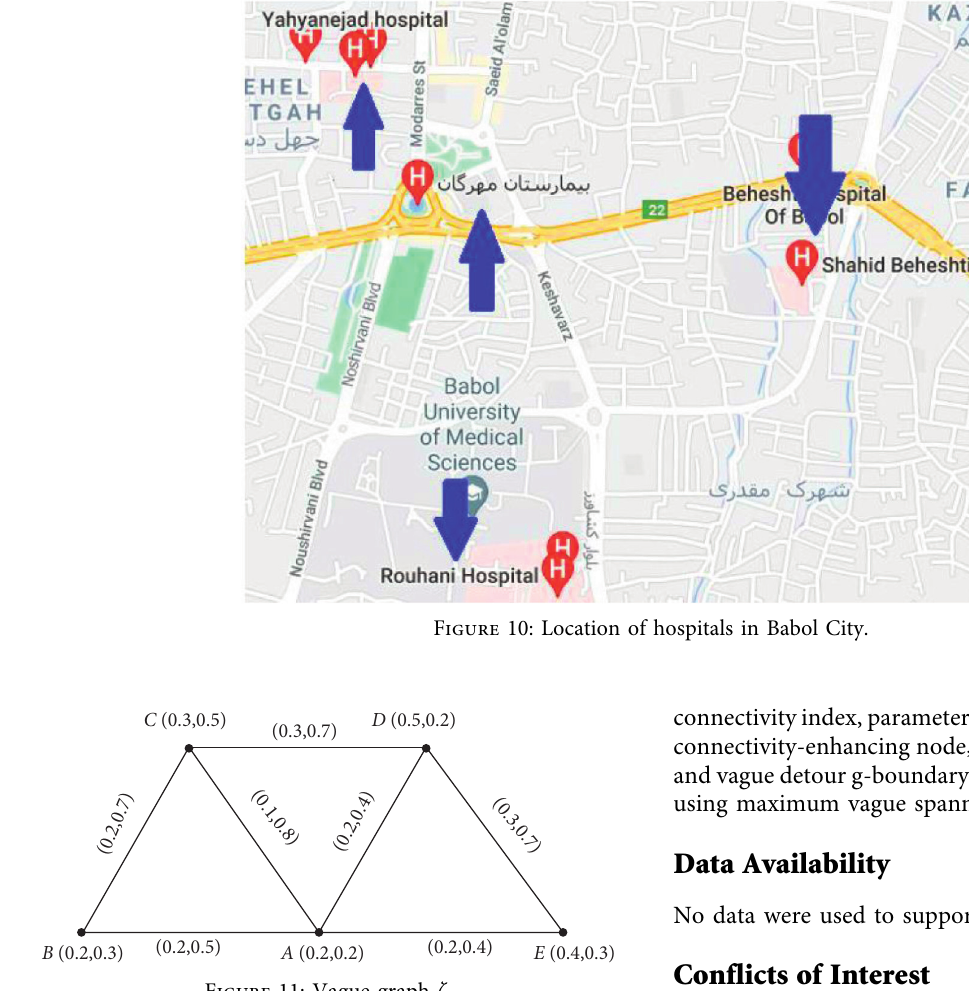
Figure 11: Vague graph ζ